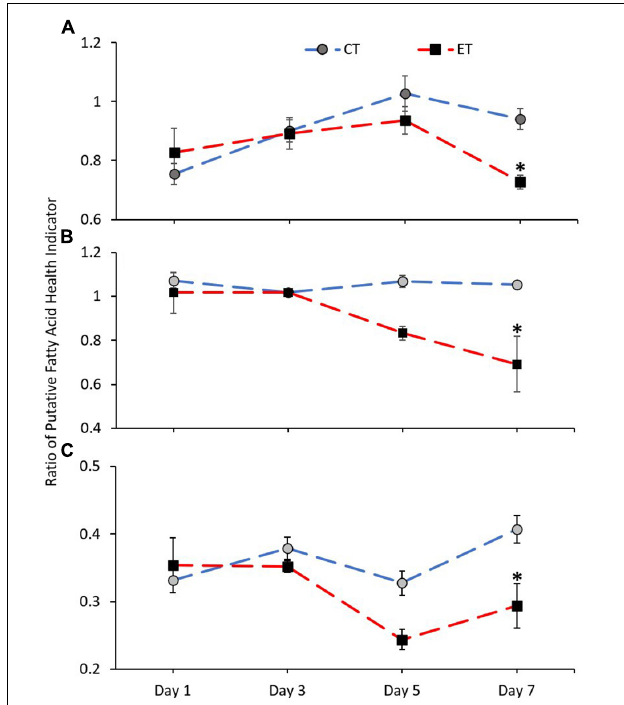
FIGURE 8 | Ratio of coral health indicators ( A = n-3 LC:n-6 LC, B = EPA:ARA, and C = DHA:ARA) in coral samples from CT and ET during the experimental period. All data points are mean ± SE ( n = 9). Asterisk represents a significant difference ( p < 0.05).